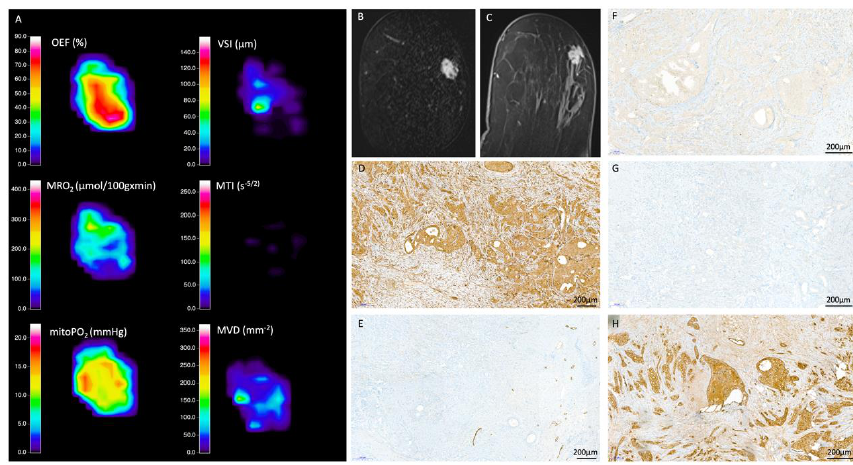
Figure 1. Radiologic-histopathologic correlation: 58-year-old patient with an invasive ductal carcinoma (estrogen receptor (ER)/ progesterone receptor (PR) positive and human epidermal growth receptor 2 (HER2) negative, ki-67 20%). ( A ) MRI biomarkers ( B ) Contrast enhanced T1 (CE-T1) image coronal ( C ) CE-T1 image axial ( D ) vascular endothelial growth factor receptor 1 (FLT1) ( E ) podoplanin